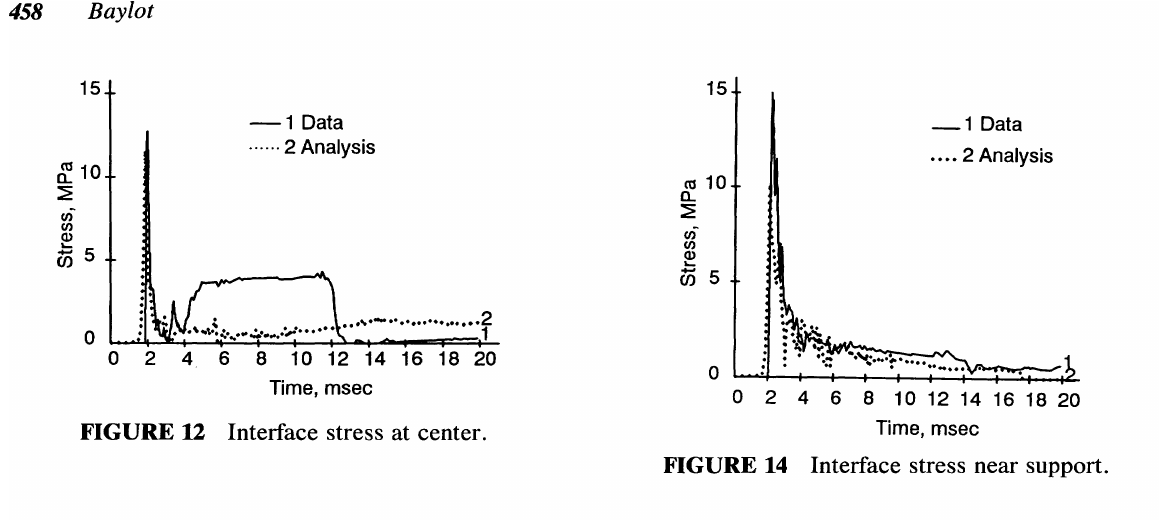
FIGURE 14 Interface stress near support.